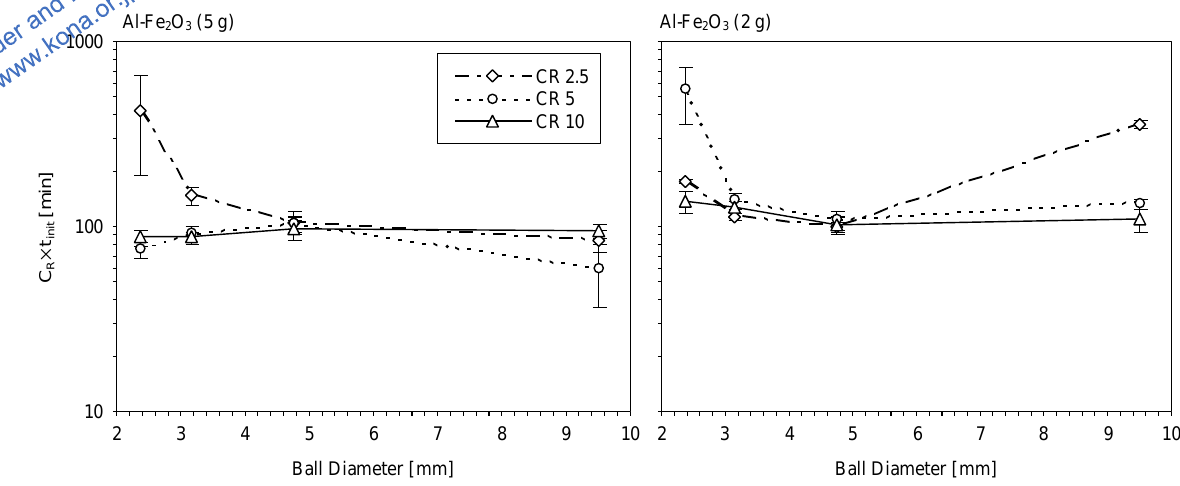
Fig. 7 Experimental data on reactive milling of 2Al (cid:4) Fe 2 O 3 composition presented as the product of the charge ratio and milling time plotted versus ball size for different charge ratios.